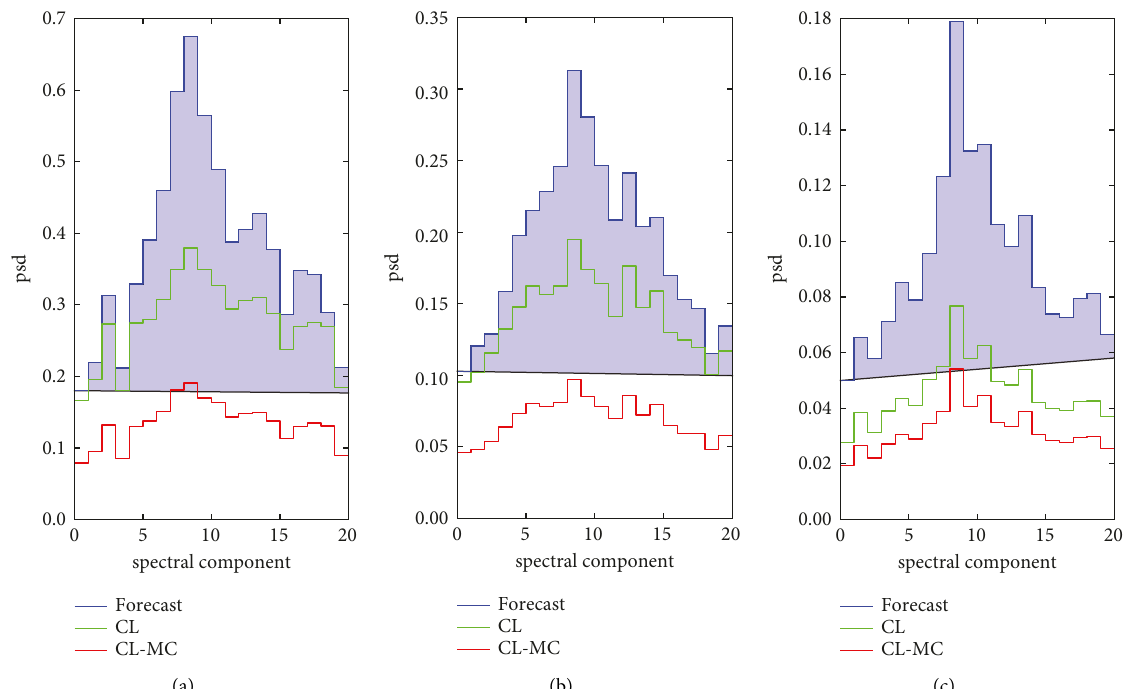
Figure 2: Influence of the CL and CL-MC algorithms on the PSD with the different localization radii. (a) Localization radius � 10. (b) Localization radius � 15. (c) Localization radius �